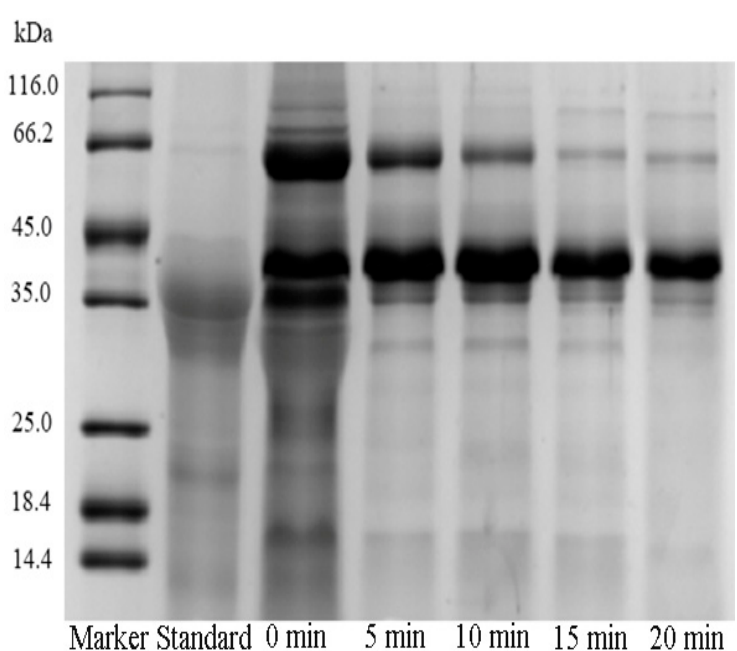
Figure 2. SDS-PAGE of Pv for different heating times (0, 5, 10, 15, and 20 min). Other operating conditions: Heating temperature, 80 °C; ultrasound power, 600 W; and ultrasound time, 10 min. Table 1. E ff ect of heating time (min) on purity, N / P and activity of